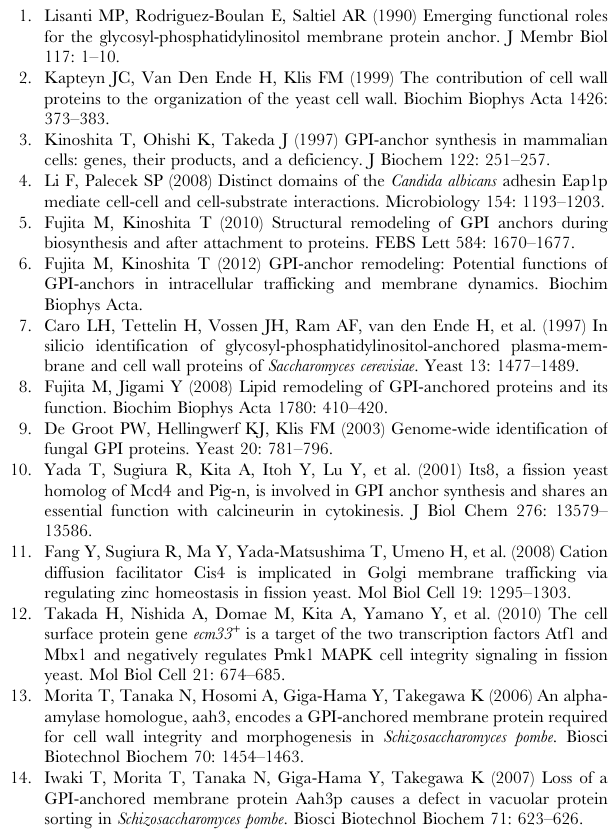
Table S1 Strains used in this study. Table S2 Primers for construction of truncated Ecm33. Table S3 Primers for cloning or tagging of the ecm33 + , gaz2 +